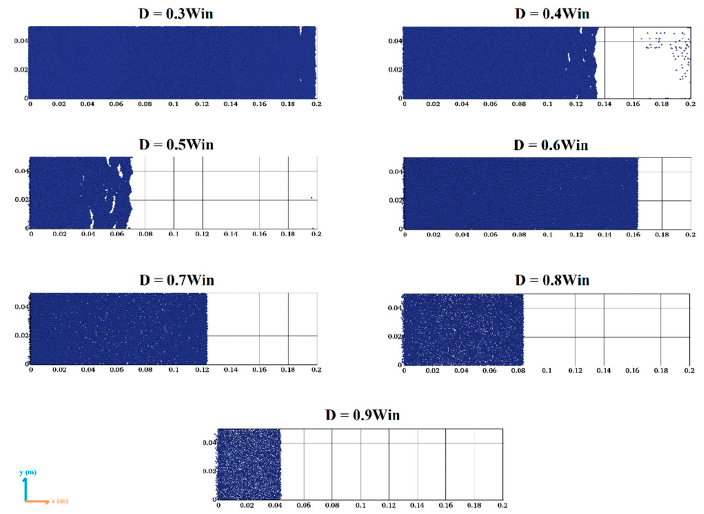
Figure 8. Successful bridging in all simulated particle diameters.